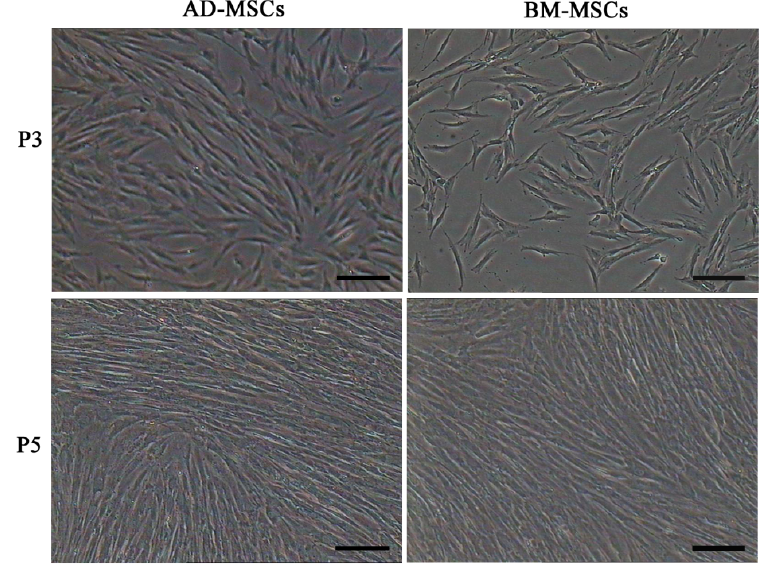
Figure 1. Morphology characteristics of adipose-derived mesenchymal stem cells (AD-MSCs) and bone marrow-derived mesenchymal stem cells (BM-MSCs). Scale bars, 100 μ m. (Original magnification,